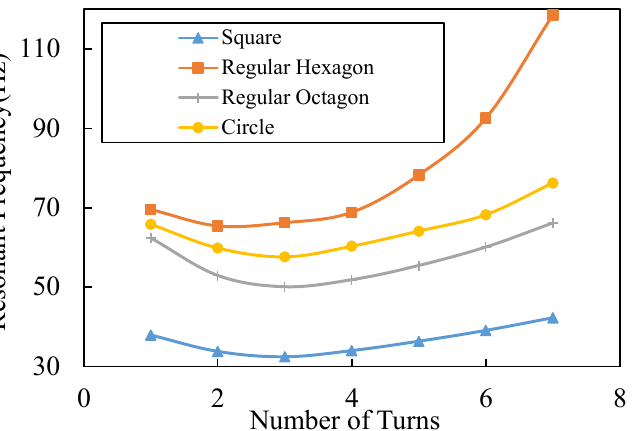
Figure 5. Analytical results of the resonant frequencies versus the number of turns of the beams in different